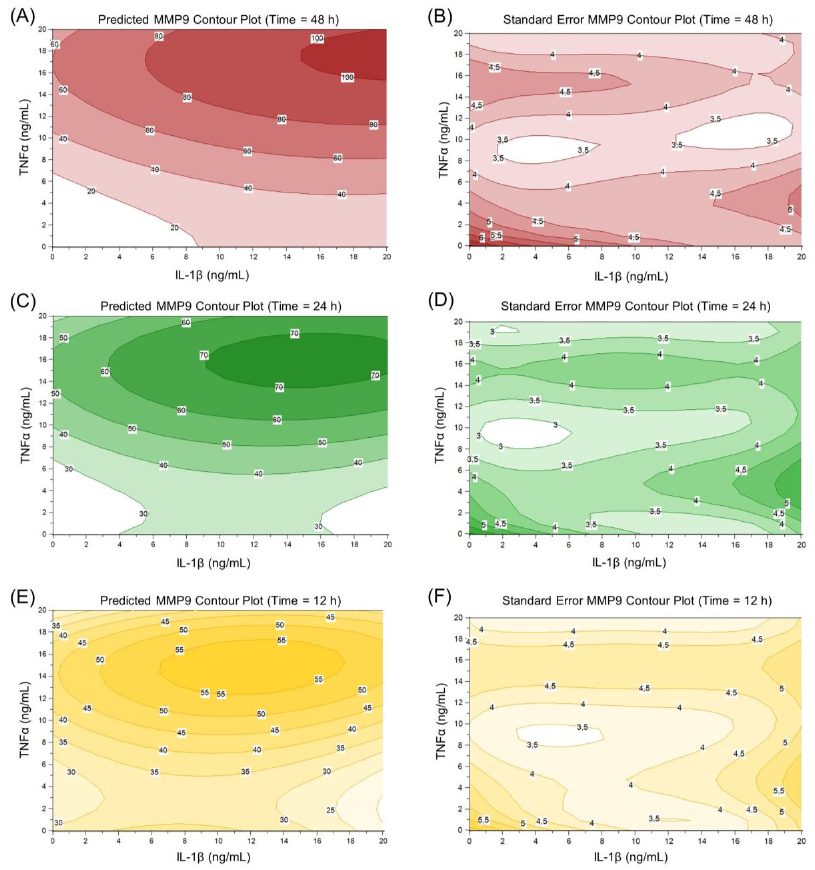
Figure 8. Contour plot of predicted MMP9 expression and standard error at 48 h ( A , B ), 24 h ( C , D ) and 12 h ( E , F ) depending on TNFα and IL - 1β concentr